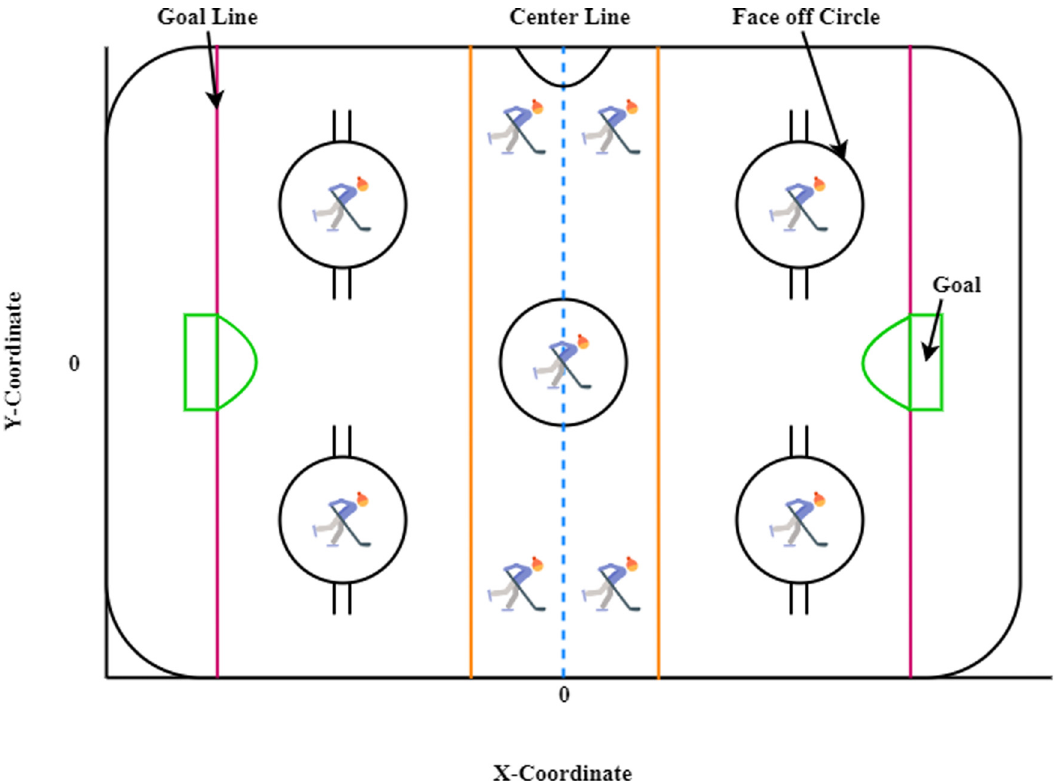
Figure 1: Ice hockey